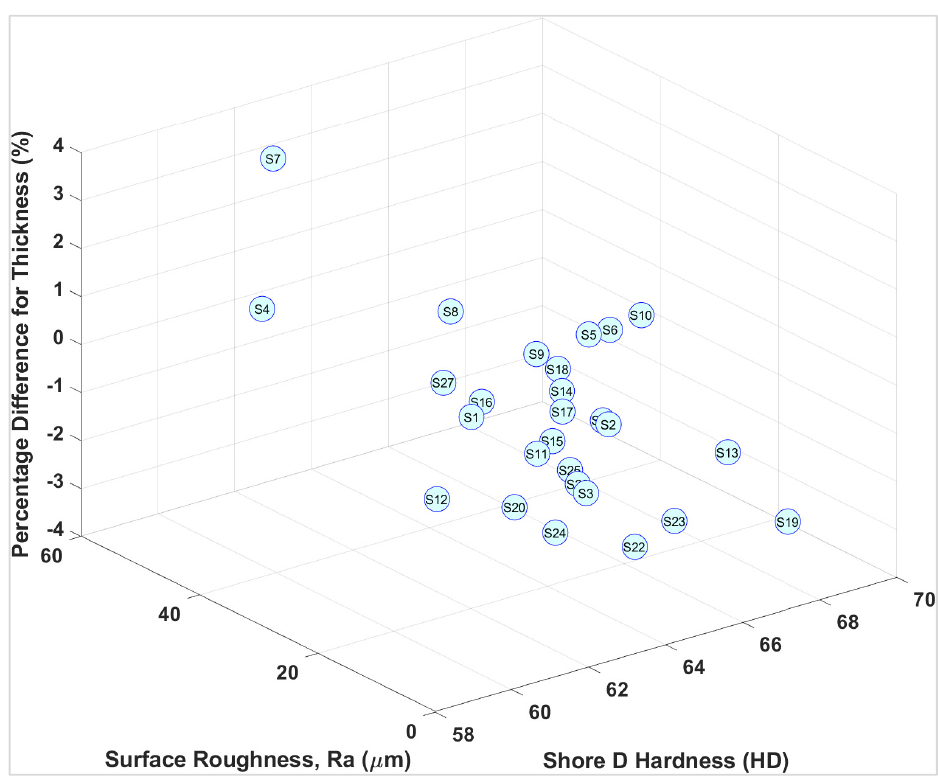
Figure 10. Three-axis plot for ASA material.